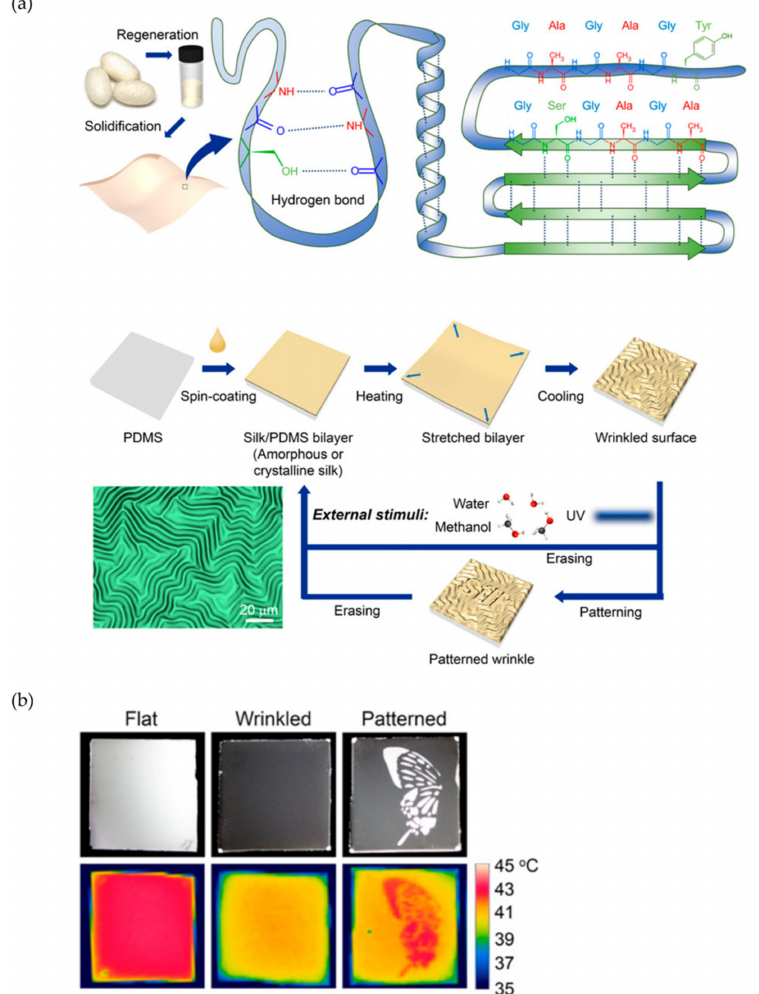
Figure 3. ( a ) Schematic representation of the reconstituted silk-fibroin molecular structure and schematic representation of the process to fabricate the reversible wrinkled patterns. ( b ) Photographs (top) and IR images (bottom) of the flat surface (left), surface with wrinkled structure (middle), and surface with a wrinkled pattern (right). Reproduced with permission from reference [40]. Copyright 2019, Proceedings of the National Academy of Sciences